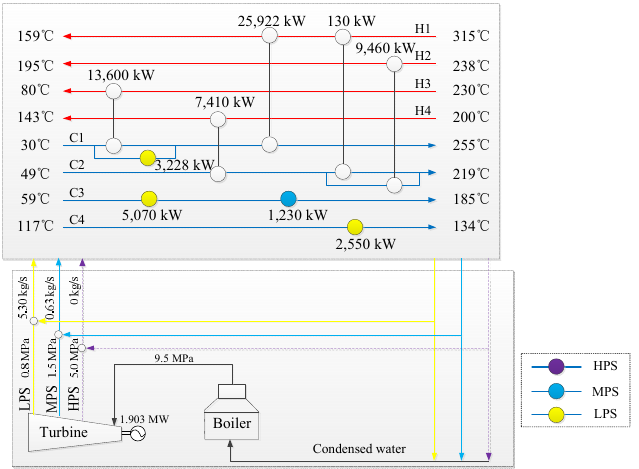
Figure 4. Structure with minimum TAC of Scenario 3